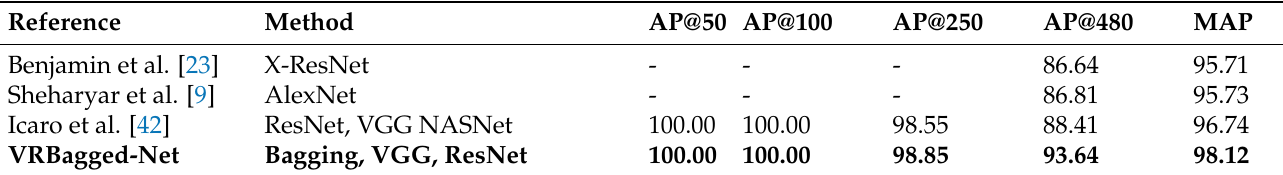
Table 2. DIRSM Dataset: Comparison of VRBagged-Net with state-of-the-art methods.